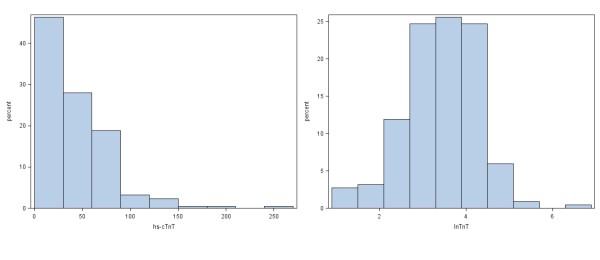
Distribution of high-sensitivity cardiac troponin T. The distribution of high-sensitivity cardiac troponin T (hs-cTnT, left panel) and their natural logarithms (lnTnT, right panel) in 219 admissions among 99 patients with acute exacerbation of COPD. In the left panel, an outlayer (hs-cTnT = 609 ng/L) has been removed.